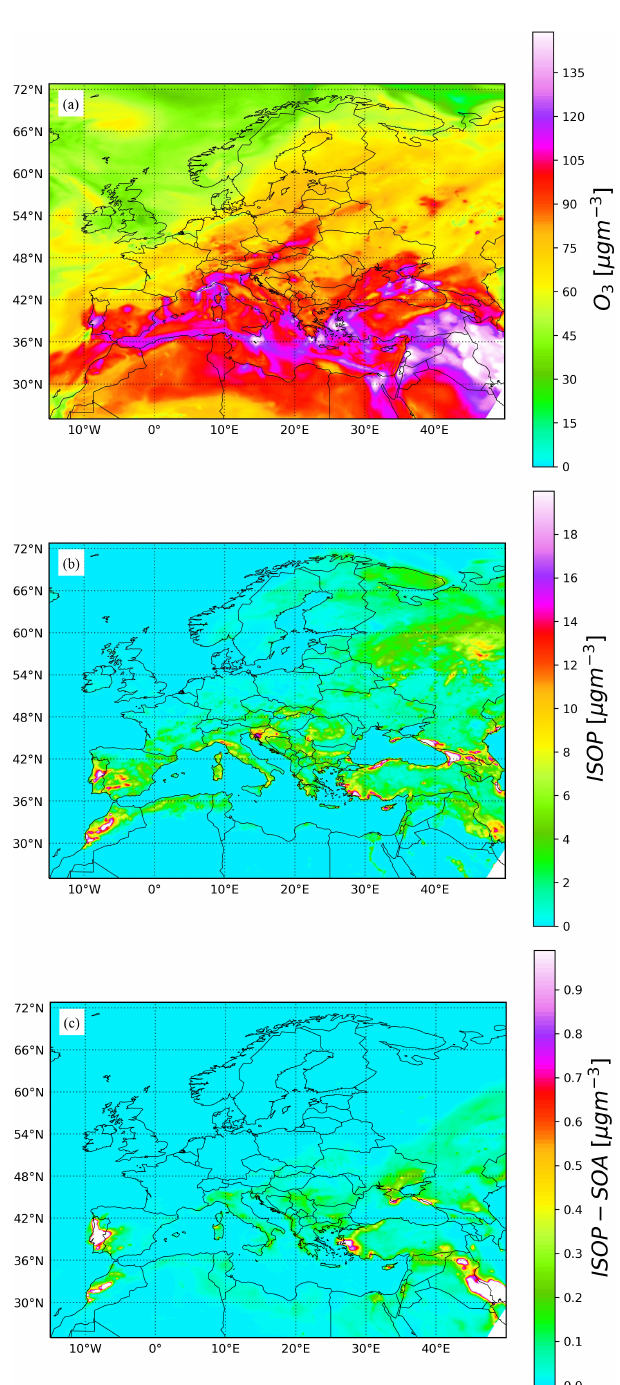
Figure 10. Surface concentration of (a) ozone, (b) isoprene, and (c) total isoprene secondary organic aerosol for 9 August 2016 at